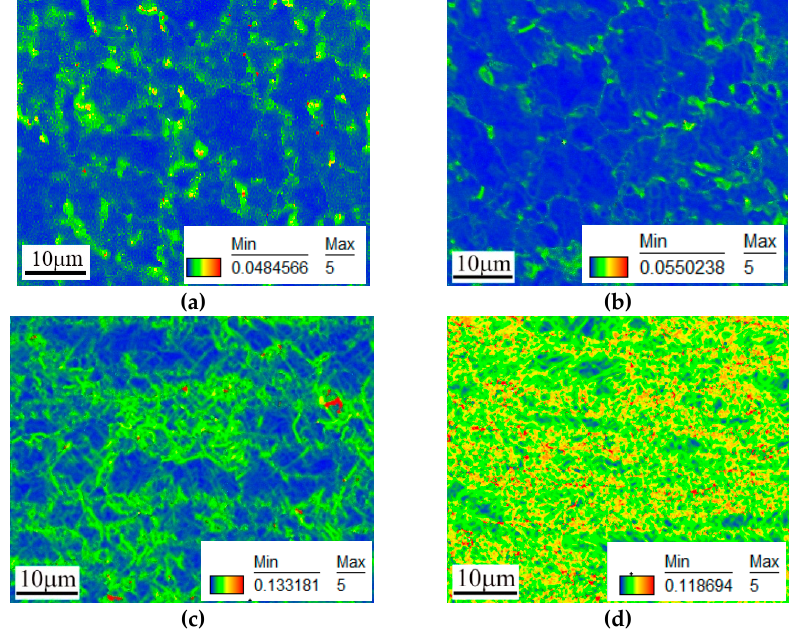
Figure 15. Misorientation distribution of grain boundaries in the martensite phase zone; ( a ) before tensile test; ( b ) after tensile test. tensile test; ( b ) after tensile test.